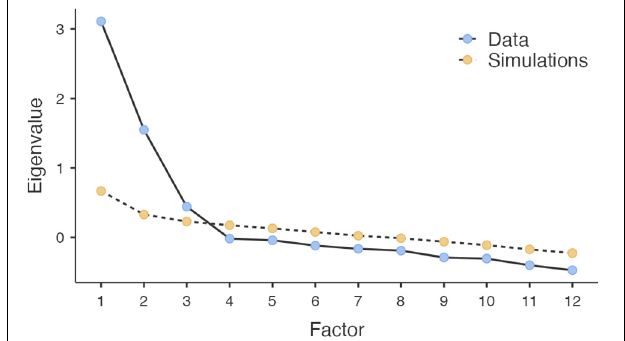
FIGURE 2 | Scree plot with data and simulations (parallel